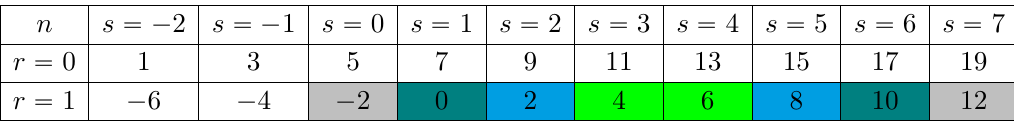
Table 2 . Values of the momentum n of some operators in the p 2 , 7 q compact linear dilaton. The correct truncated fusion range for the model is shaded in blue and